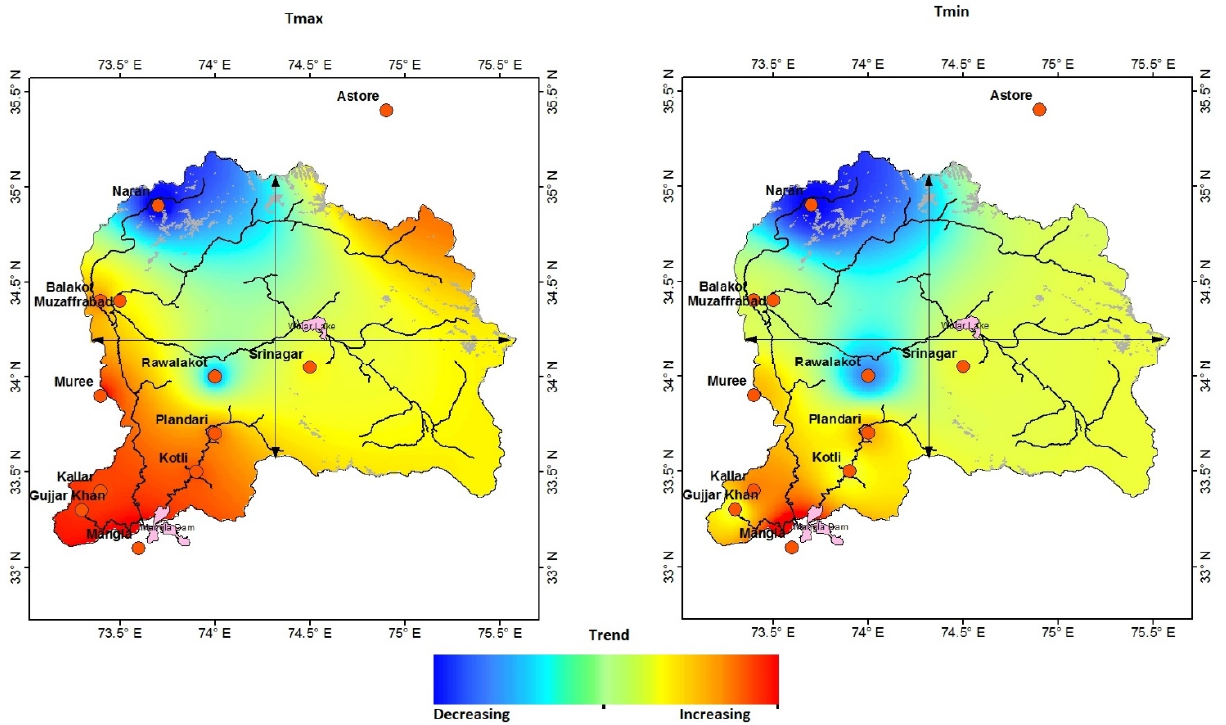
Figure 2. Trends of Annual Maximum and Minimum Temperature Over the Northwest Himalayas (water lakes represented in pink color). Table 4. Trends of absolute temperature indices slopes and